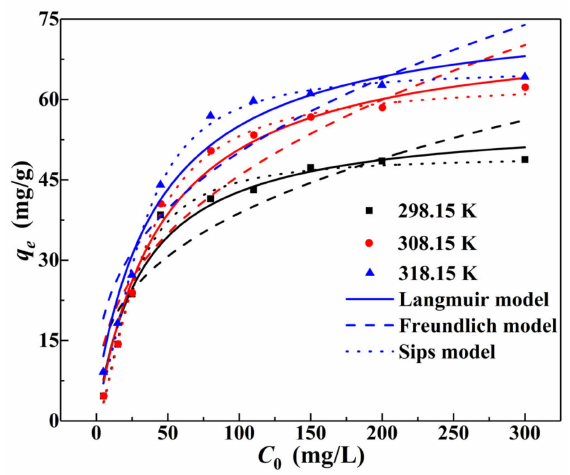
Figure 12. Adsorption isotherm fitting curves of Cr(VI) on the α